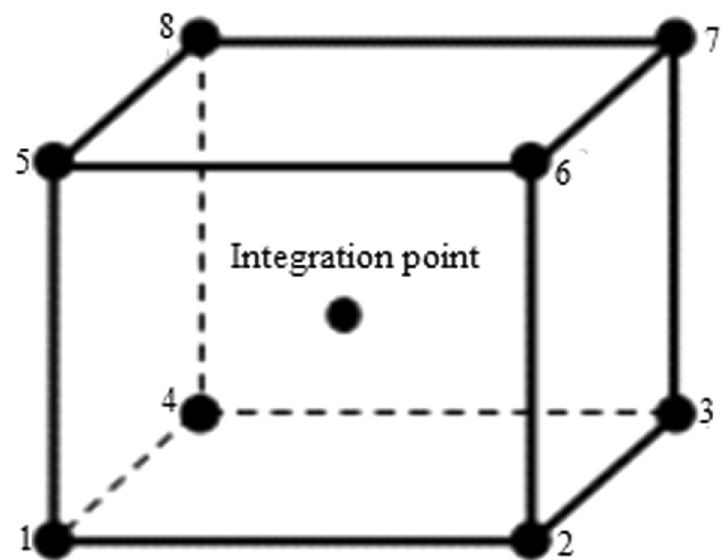
Fig. 8 Three-dimensional eight-node linear hexahedral (brick) element with reduced integration (C3D8R)